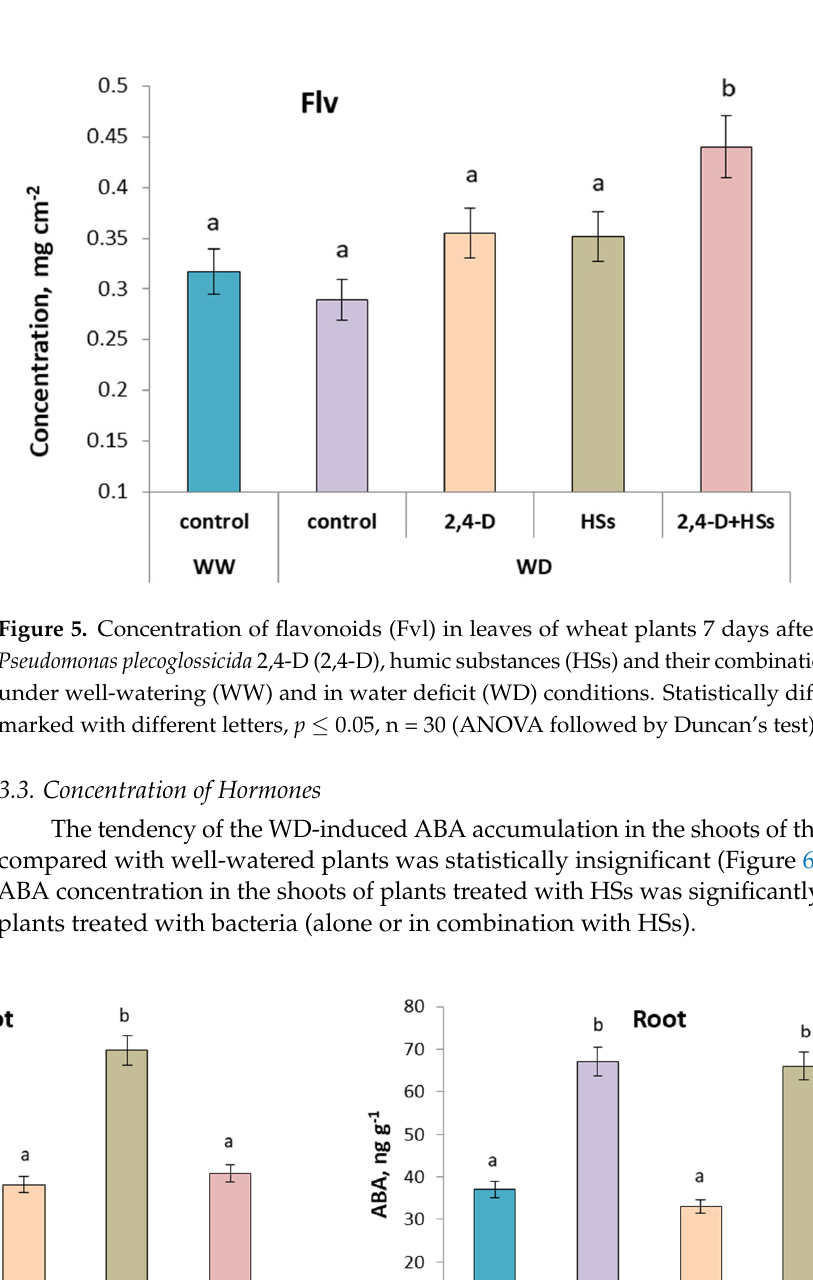
Table 8. ANOVA test for shoot ABA content followed by Duncan test. Values in the cells correspond to p for the difference between the mean values; p ≤ 0.05 is marked with *; p ≤ 0.01—with ** for control plants untreated with either bacteria or HSs and plants grown under water deficit (WD): control, plants treated with Pseudomonas plecoglossicida 2,4 ‐ D (2,4 ‐ D), humic substances (HSs) and their combinations (2,4 ‐ D + HSs).